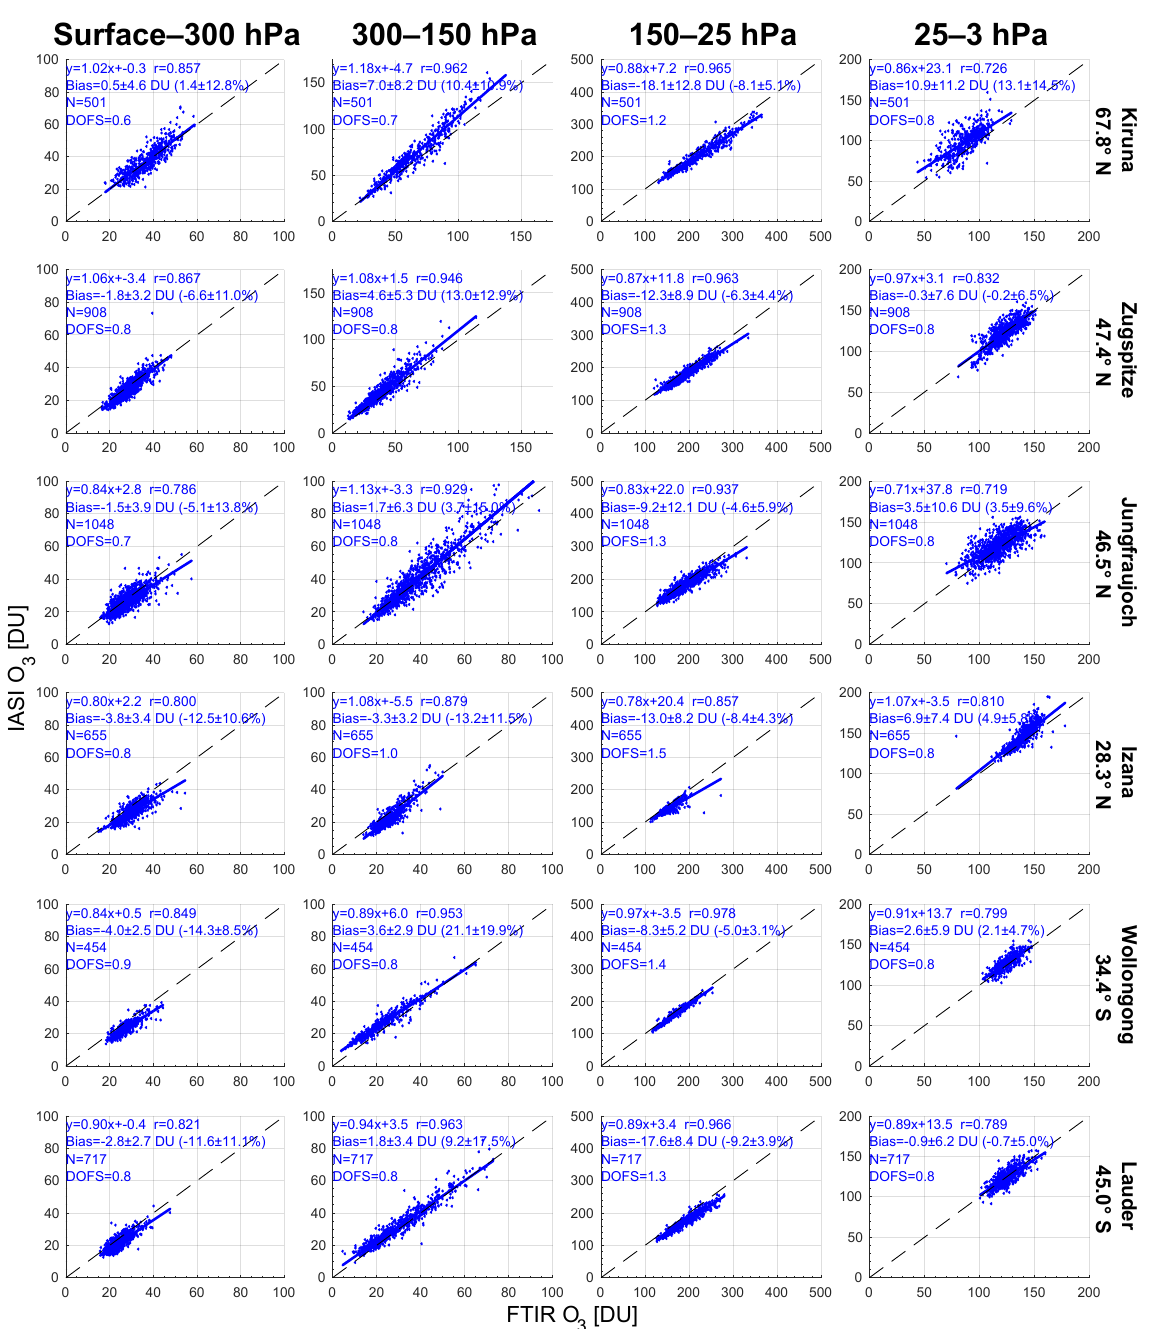
Figure 13. Scatterplots of IASI-A against smoothed FTIR O 3 partial columns at the six FTIR stations for the period from 2008 to 2017. Comparison statistics including the linear regression, the mean bias, the 1 σ standard deviation in both Dobson units (DU) and percent (%), the number of collocations and the mean DOFS for each partial column are shown on each